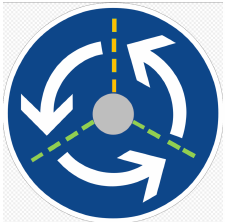
Figure 5. Synchronous rotating priority sectors roundabout (SYROPS)